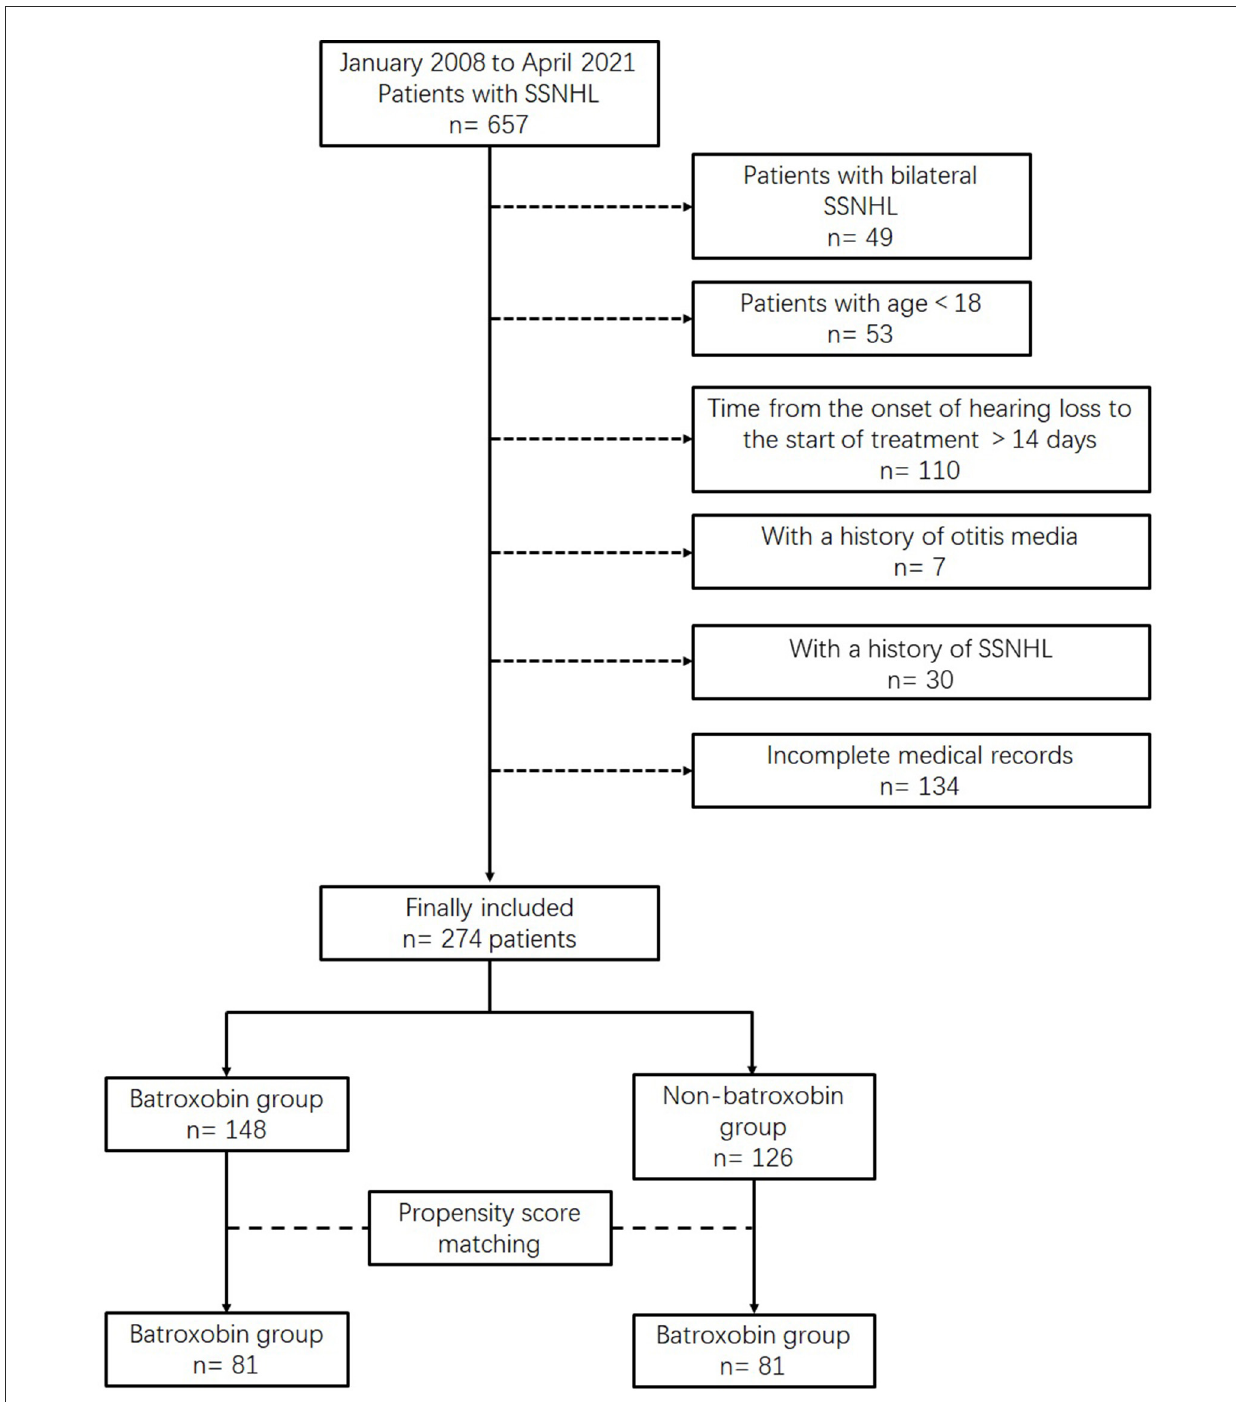
FIGURE1 Flowchart depicting patient selection.